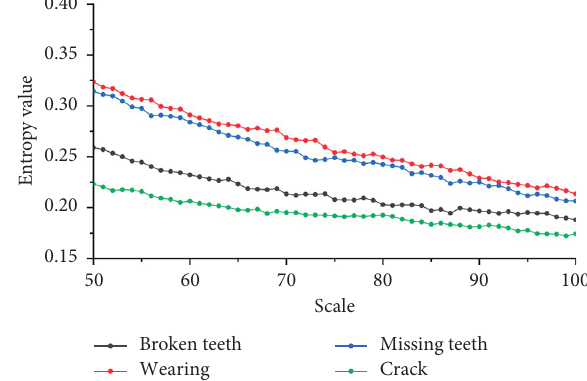
Figure 12: DCSMDE value curve after flattening.